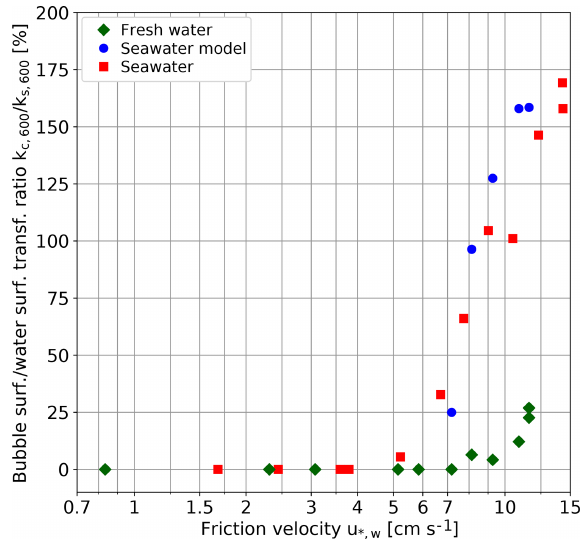
Figure 9. Comparison of DMS and carbon dioxide gas transfer velocities in a double-logarithmic representation: eddy covariance measurements from the High Wind Speed Gas Exchange Field Study (HiWinGS) by Blomquist et al. (2017) (Blom) including their k(u 10 ) parameterizations. Also shown are the CO 2 and DMS trans- fer velocities measured by Zavarsky et al. (2018) (Zav) and those reported in Bell et al. (2017) (Bell). For the Bell data, power laws of the form a u n taken from Brumer et al. (2017) are shown. The 10 output of the model presented in this paper for CO 2 and DMS is also